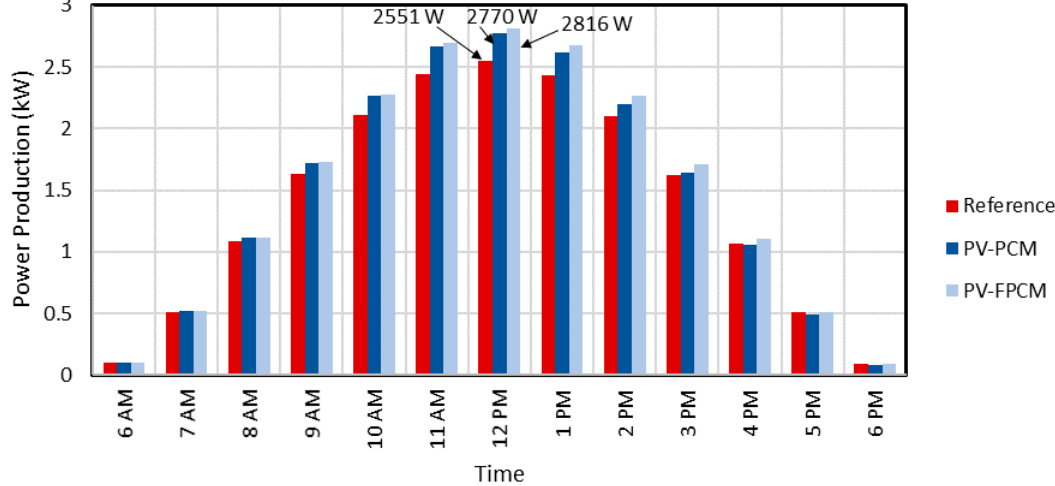
Figure 5. Power production by reference system, PCM cooled system and FPCM cooled system.